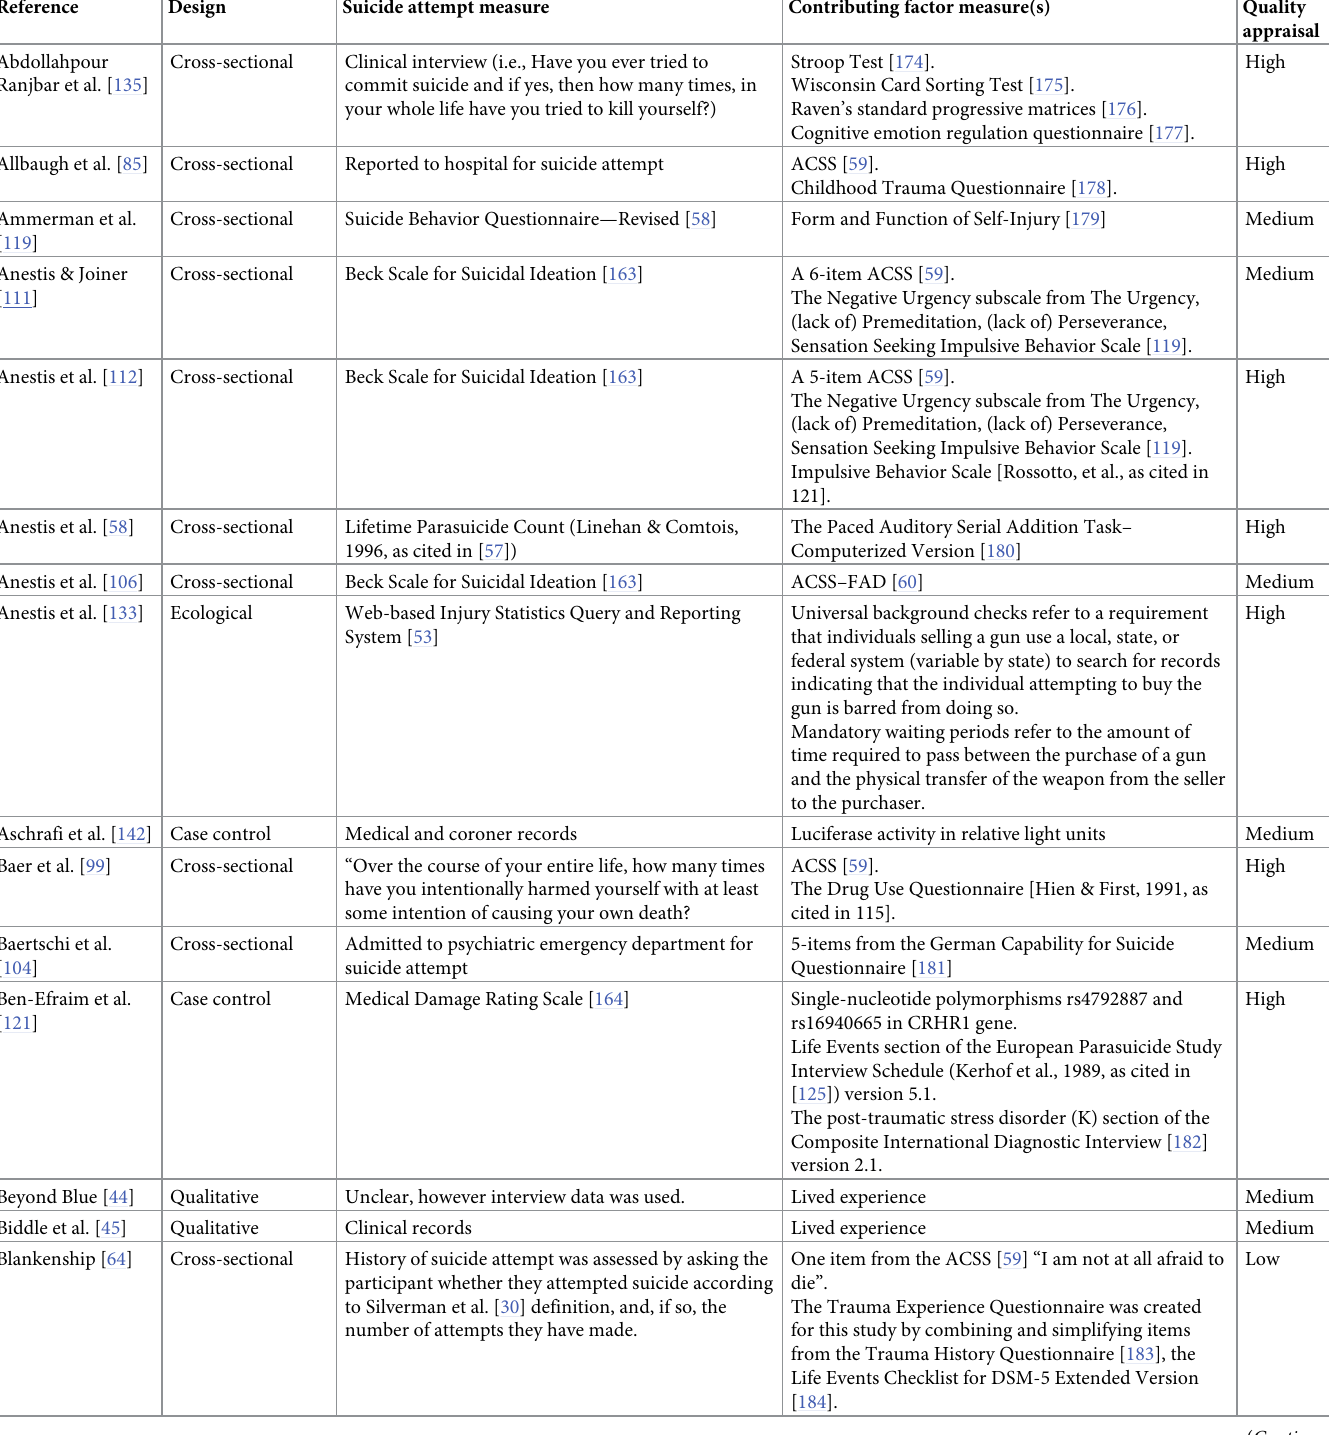
Table 2. Study methodologies and